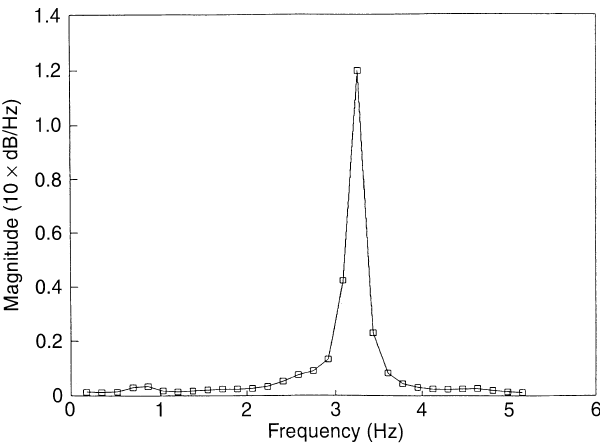
Fig. 3. a Well-resolved quasiperiodic patterns recorded on 11 March, 1991 are seen here. The fading time is found to be about 0.3 s; b well- developed quasiperiodic pattern recorded on 15 March, 1991 is shown here. Modulation envelopes are clearly seen